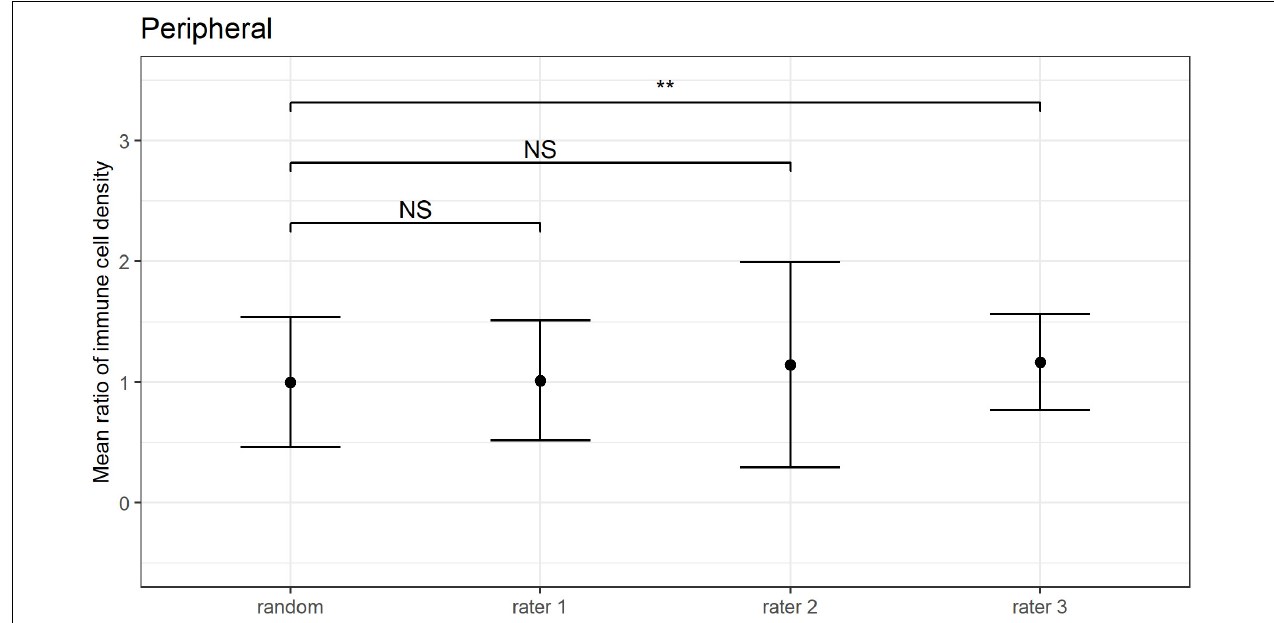
FIGURE 7 | Peripheral corneal epithelial immune cell (IC) density mean ratios, and corresponding 95% CIs, obtained when IC density estimates derived from all combinations of three randomly sampled images (random), and when the “three representative images” were independently selected by three observers (i.e., raters 1 to 3). Mean ratios of IC density estimates derived from images selected by rater 3 were significantly higher in comparison to 3 randomly selected images (** p < 0.01; NS: p >